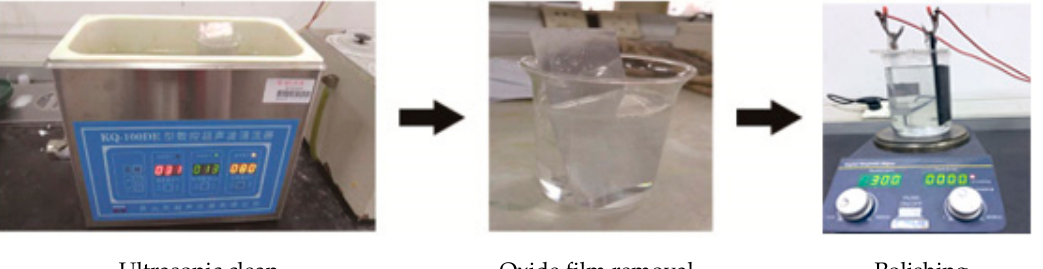
Figure 2. Pretreatment of the aluminum